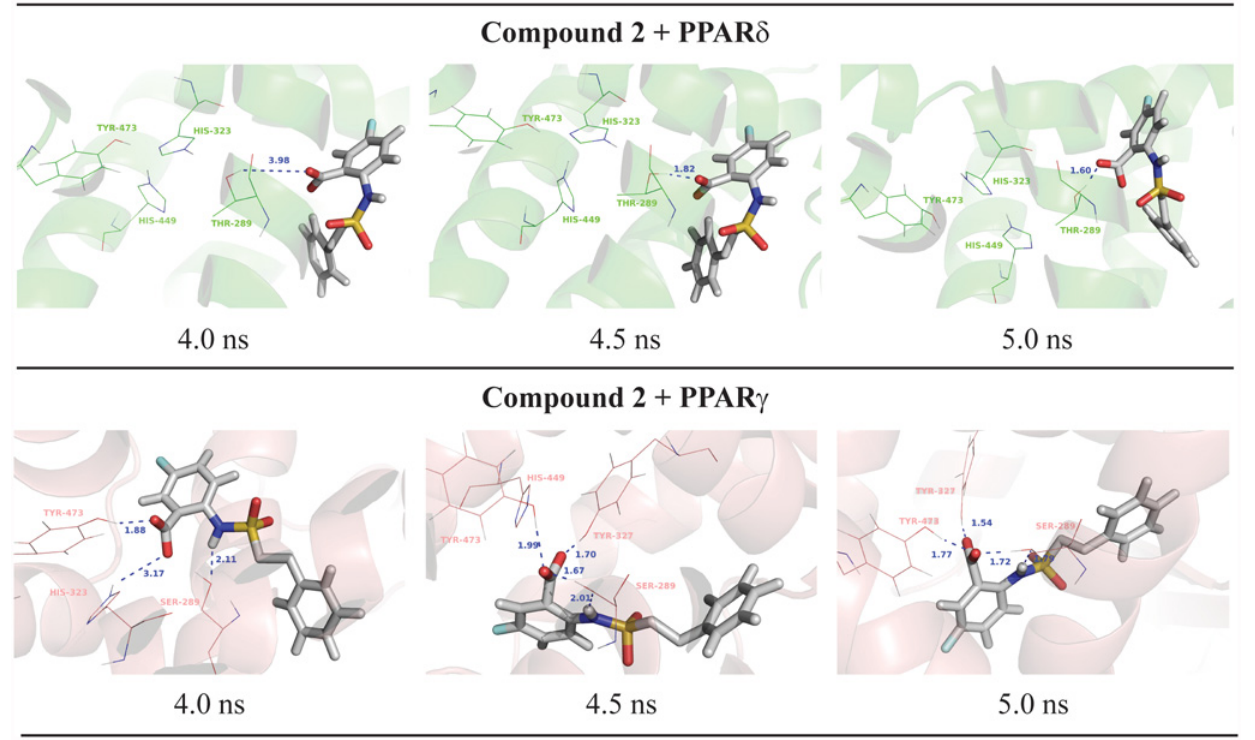
Fig 4. Final nanosecond snapshots of compound 2 molecular dynamic simulations in complex with PPAR subtypes. Main polar interactions between the compound 2 and the PPAR δ and PPAR γ during the final nanosecond of MD simulation.